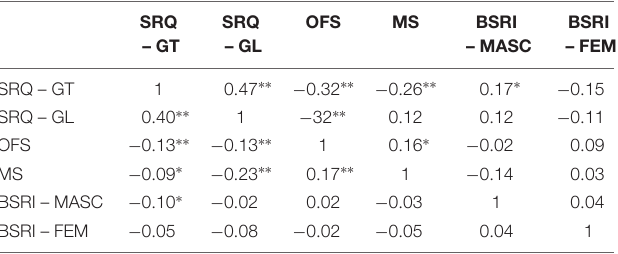
TABLE 7 | Correlations for SRQ, MS, OFS, and BSRI for males ( n = 176) and females ( n = 524). SRQ SRQ OFS MS BSRI